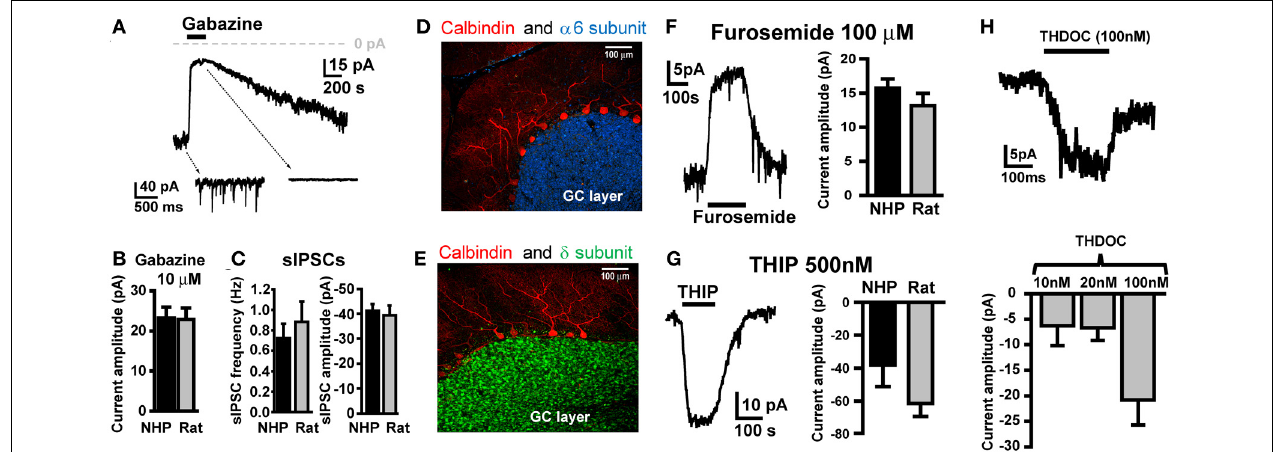
FIGURE 1 | NHP and SDR GCs exhibit similar magnitude tonic currents mediated by α 6 and δ subunit containing GABA A Rs. (A) Example trace showing block of tonic current and sIPSCs by GABA A R antagonist GABAzine (10 μ M) in GCs from NHPs. Note, in this and all other figures, the dashed arrows point to an expanded time scale of recording from different time points of the main traces (coming from the region of the main trace that the back of the arrow extrapolates to), showing sIPSCs and block by GABAzine. (B) Plot summarizing mean amplitude of tonic current blocked by GABAzine (10 μ M) in NHP (black; n = 37 GCs from 10 animals) and SDR (gray; n = 16 GCs from 7 animals) GCs. (C) Plot of mean frequency (left) and amplitude of sIPSCs (right) in NHP (black; n = 71 GCs from 12 animals) and SDR (gray; n = 64 GCs from 26 animals) GCs ( D,E) . Confocally acquired fluorescence images of cerebellar slices from an NHP showing α 6 (blue stain in D ) and δ (green stain in E ) subunits of the GABA A R expression exclusively in the granule cell layer (beneath the Purkinje cell layer, labeled red with antibody to Calbindin). (F) Example trace (left panel) showing block of tonic current by GABA A R antagonist furosemide